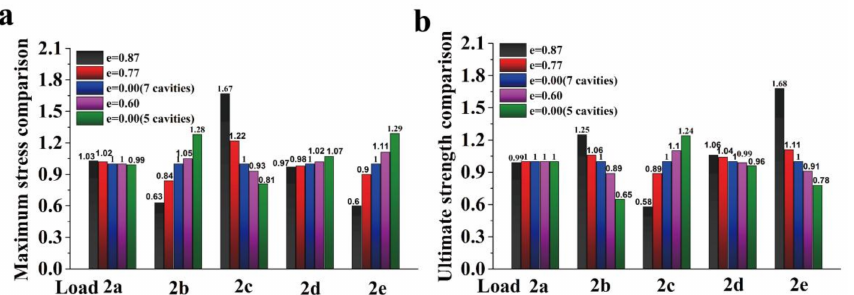
Figure 6. Effect of the eccentricity on the mechanical properties: ( a ) maximum stress comparison under elastic loading, and ( b ) ultimate strength comparison under failure simulation.